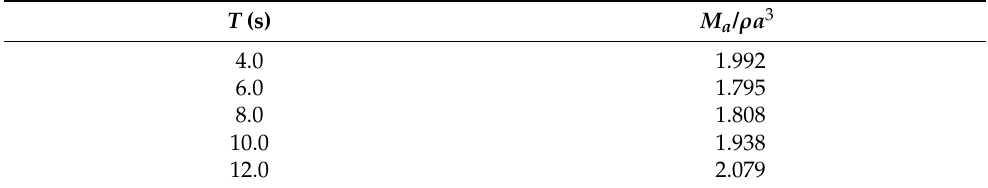
Table 2. Nondimensional M a values for different oscillation periods for a cylinder of a = 10.0 m and b / a = 1.0 placed at d = 20